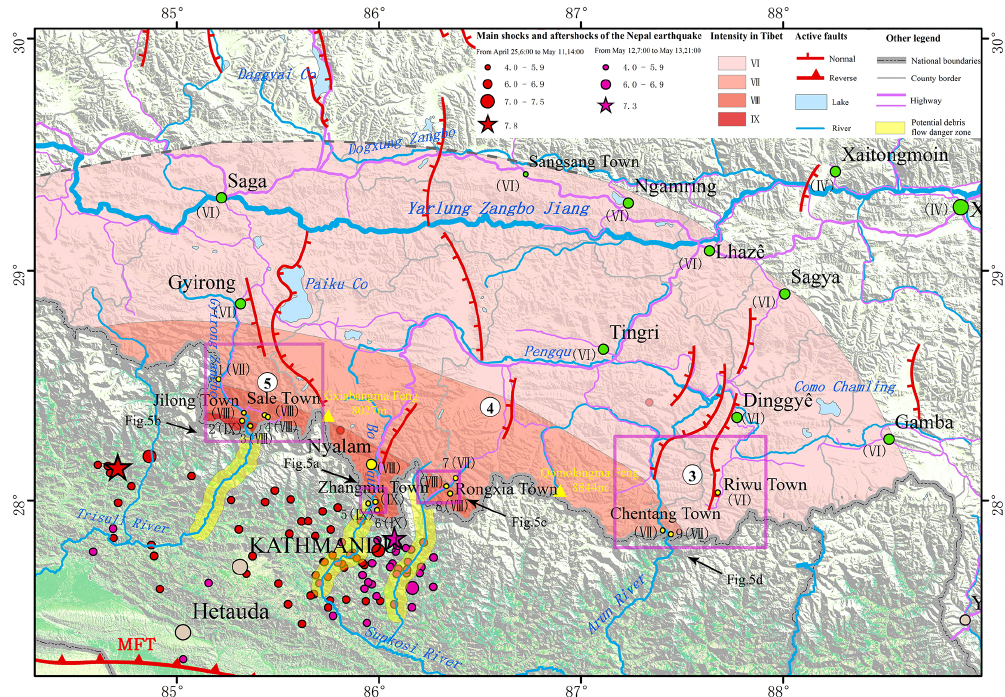
Figure 2. Principal active faults and the distribution of seismic intensity of the 2015 Nepal earthquake in the southern Tibet region. Epicentral data are from the USGS, and seismic intensity data are from the China Earthquake Administration. The numbers and names of the principal S–N-trending rifts in southern Tibet are same as on Fig. 1. The green circles show the sites of which intensities are from the China Earthquake Administration, and yellow circles show the spots of which intensities are resulted from our field investigation. The survey spots are denoted as follows: (1) Rema Village, (2) Jifu Village, (3) Chongse Village, (4) Guoba Village, (5) Kodari, Nepal, (6) Lixin Village, (7) Bangse Village, (8) Zhuobude Village, and (9) Natang